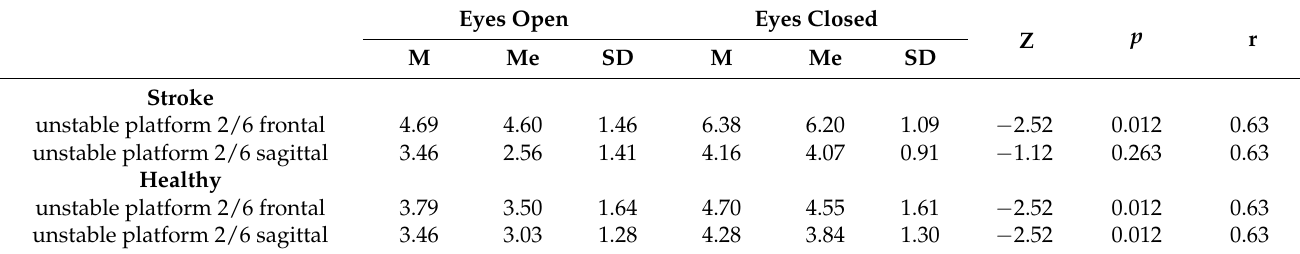
Table 5. Comparison of the results of measurements with eyes closed and eyes open in the group of patients after stroke. Eyes Open Eyes Closed Z p